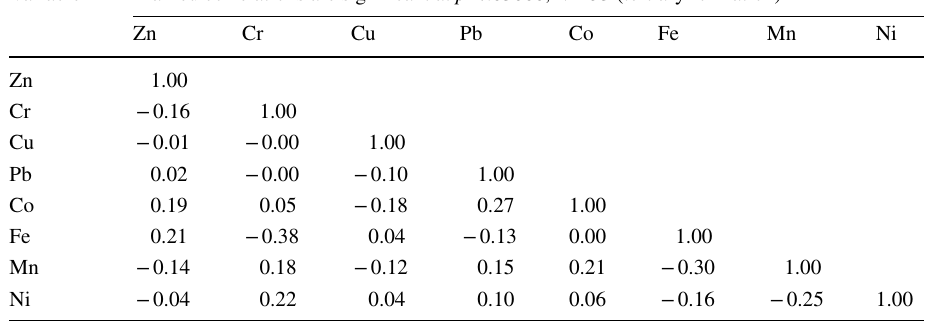
groundwater samples